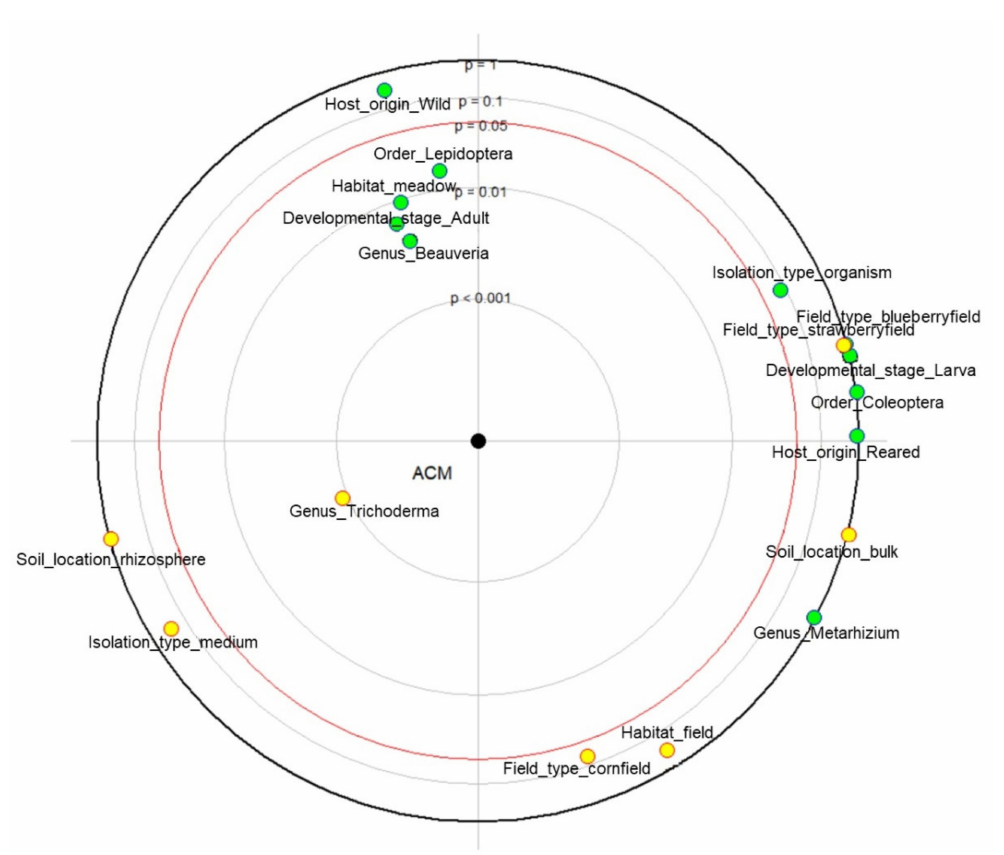
Figure 1. Correlation circle of predictor variables toward mortality rate (ACM). Green dots indicate positive correlation with the dependent variable and yellow dots indicate negative correlation with the dependent variable. Predictor variables within the red circle are significantly correlated with the dependent variable ( p < 0.05). Table 2. Growth stimulating effects of maize treated with selected fungal isolates and grown in twice autoclaved substrate for 21 days. Data presented are the mean values ± SE (n = 15 for Chapalu variety (3 replicates with 5 seeds each) and n = 30 for Belokranjka variety (3 replicates with 10 seeds each). Green fill indicates isolates with significant growth promoting properties, red fill indicates isolates with growth inhibitory properties and grey fill indicates a significant difference